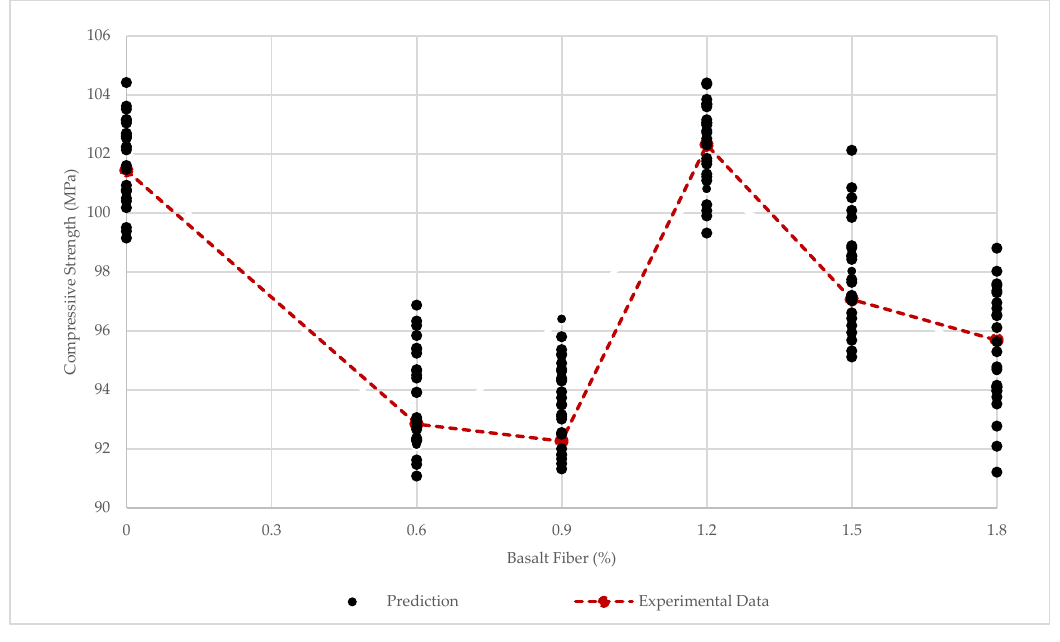
( b ) Figure 16. Flexural Strength Failure Shapes: ( a ) Basalt Fiber reinforced High-Performance Concrete; ( b ) High-Performance Concrete. 3.2. Compressive Strength Prediction The prediction and experimental compressive strength results are illustrated in Fig- ure 17. According to Figure 17, compressive strengths for more than 30 times prediction were demonstrated. In addition, the prediction errors are shown in Figure 18.